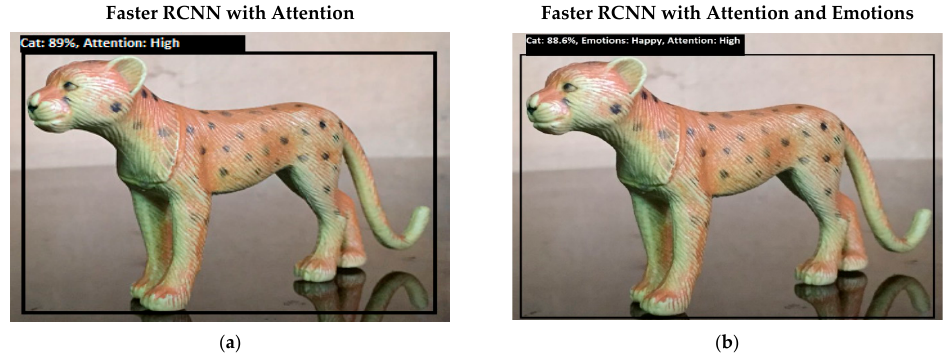
Figure 5. ( a ) Bottom-up attention-based object recognition without internal emotions. Now the system is fully focused on the lion object. ( b ) Bottom-up attention-based object recognition with the system’s internal emotions. Initially, the emotions of the system were normal, but as the system and carefully removing it from the position will increase the success and safe achievement recognizes a given object, its emotions change to fear. Fear is a strong emotional state, so it regulates of the targeted goal. a medium level of attention to a high level.